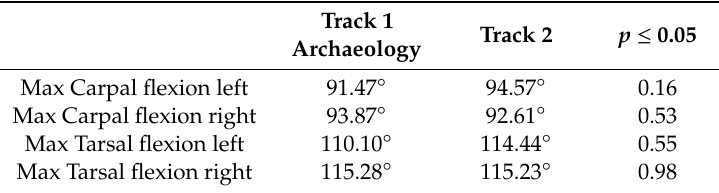
Table 1. Kinematic data output from the high speed video capture, no significant di ff erence found between the two surfaces.